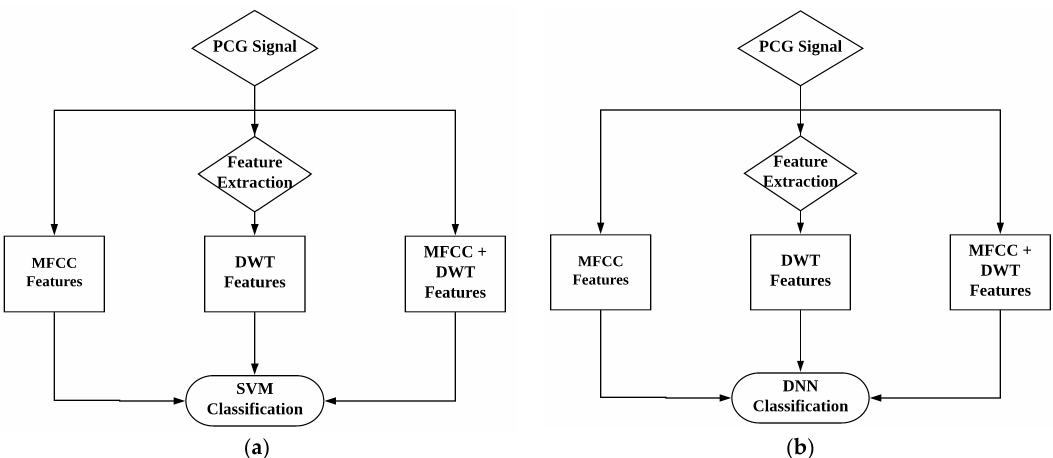
Figure 2. ( a ) Proposed heart sound signal classification algorithm using SVM; ( b ) Proposed heart sound signal classification algorithm using DNN.